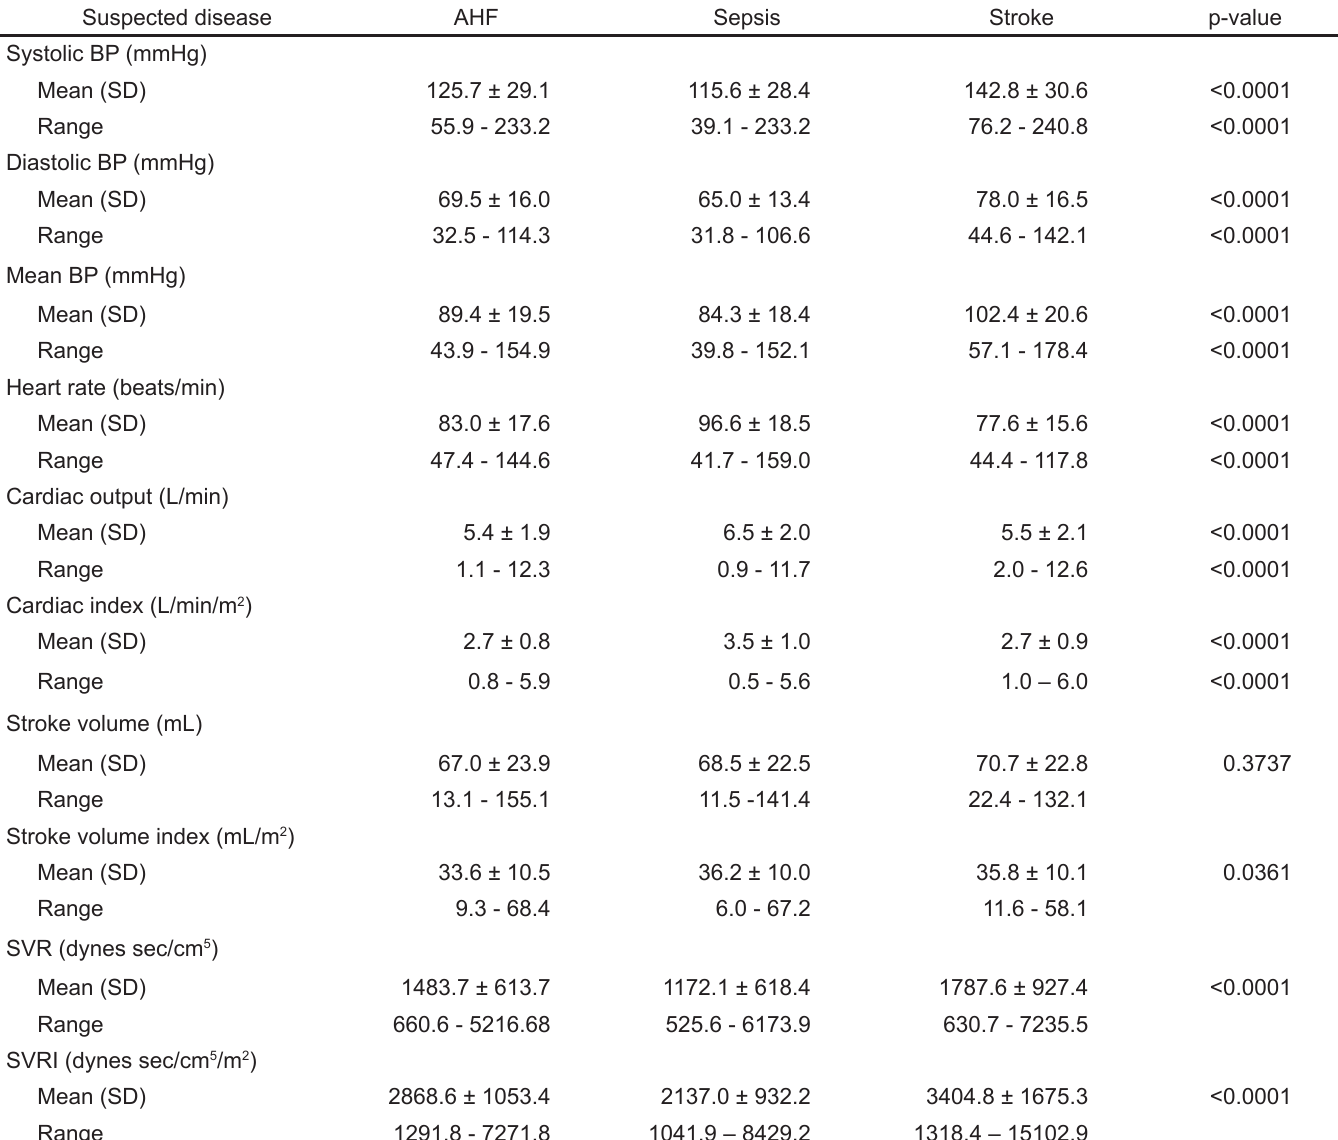
Table 3. Presenting 15-minute averaged hemodynamic